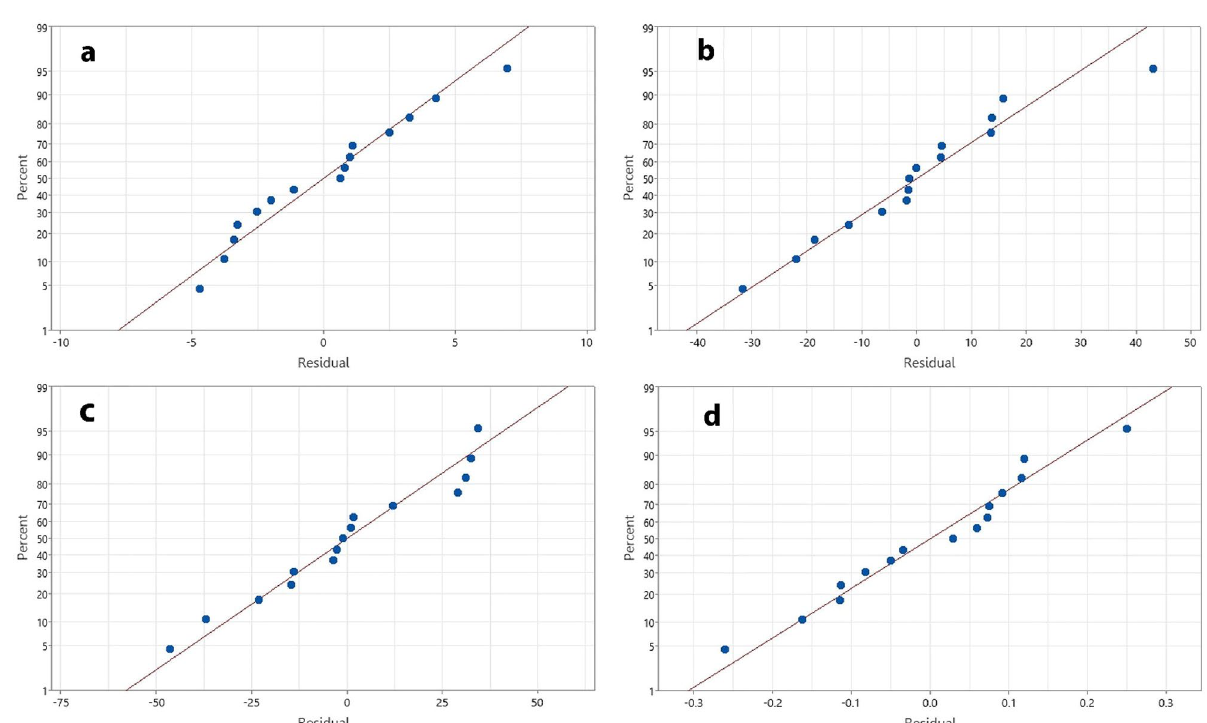
Figure 1. Normal probability plots of residuals for the extraction yield ( a ), total phenolic content ( b ), total anthocyanin content ( c ), and ABTS scavenging activity ( d